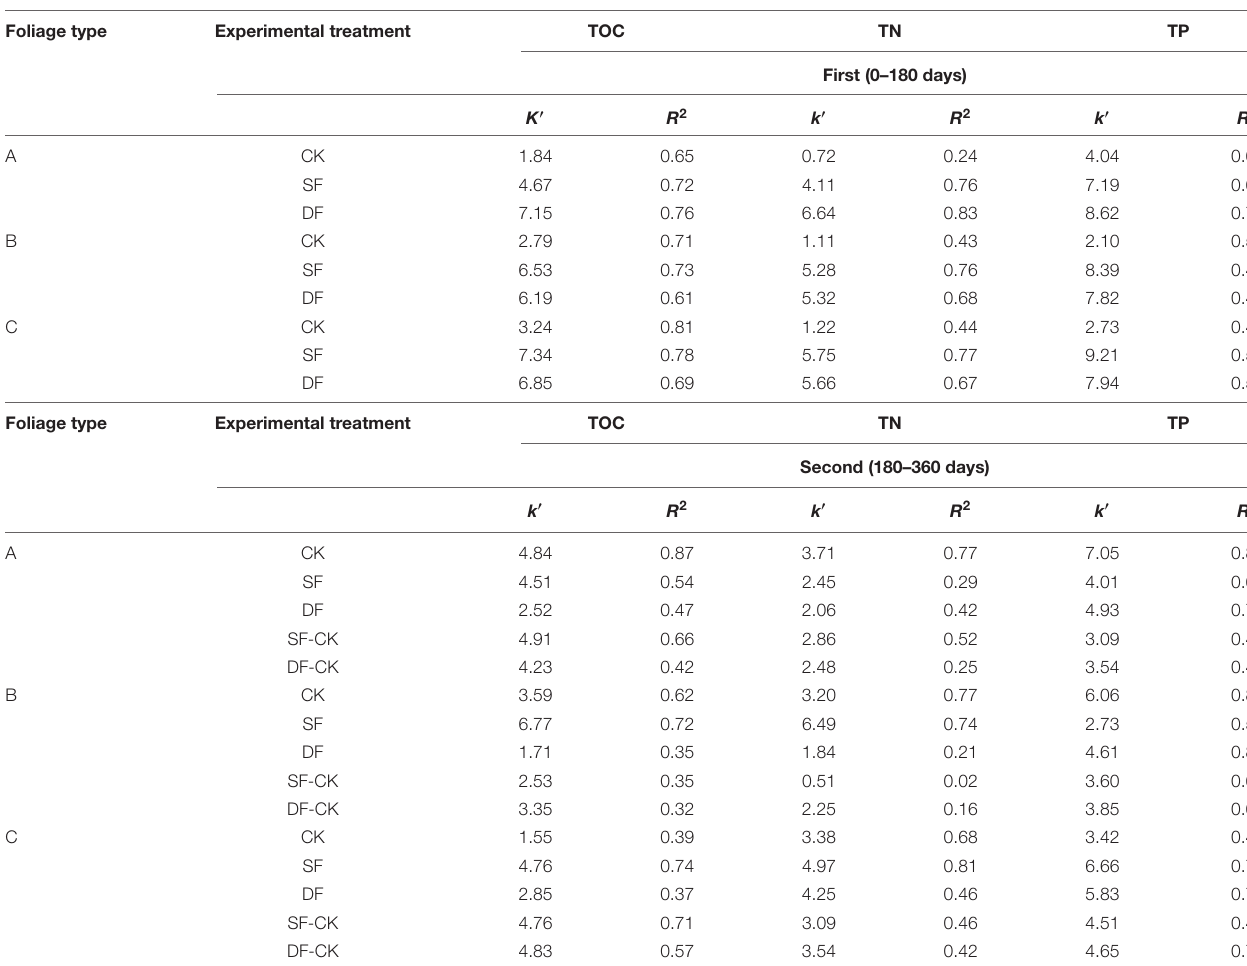
TABLE 5 | Changes in C, N, and P release rates ( k (cid:48) , g · g − 1 · day − 1 ) of leaves of Taxodium distichum (A), Salix matsudana (B), and their mixtures (C) under different experimental treatments. Foliage type Experimental